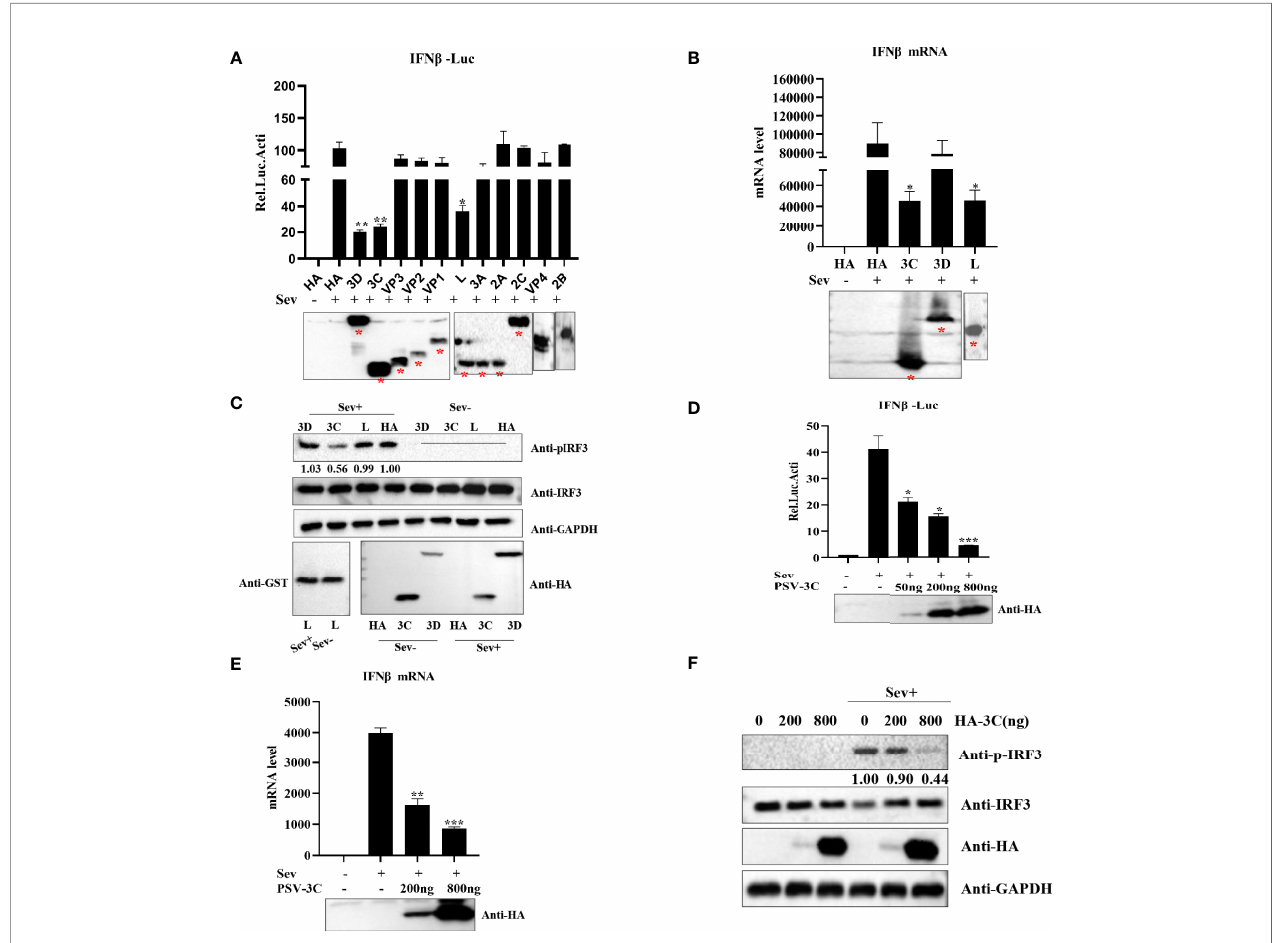
FIGURE 2 | PSV 3C pro suppresses Sev-induced type I IFN production. (A) HEK293T cells were seeded in 24-well plates, and the monolayer cells were co- transfected with 300-ng plasmids expressing indicated PSV viral protein or empty plasmids and 100 ng IFN b -Luc along with 5 ng pRL-TK for 20 h, and then the cells were infected or uninfected with Sev (2 5 HA) for 12 h. The cells were then subjected to dual-luciferase assays. PSV viral protein expression was detected by Western blotting. (B) HEK293T cells were seeded in 24-well plates, and the monolayer cells were transfected with 300-ng empty plasmids, GST- L, HA-3C, or HA-3D for 20 h, and then the cells were infected with Sev (2 5 HA) or not. The mRNA expression level of IFN- b was measured by qPCR assay, and housekeeping gene GAPDH was used as the control. L, 3C pro , or 3D expression was detected by Western blotting. (C) HEK293T cells were seeded in 12-well plates, and the monolayer cells were transfected with 500 ng GST-L, HA-3C, and HA-3D for 20 h, and then the cells were infected with Sev (2 5 HA) or not. The cells were collected for Western blotting. (D) HEK293T cells were co-transfected with different doses of 3C pro -expressing plasmids (0 ng, 50 ng, 200 ng, 800 ng) and 100 ng IFN b -Luc along with 5 ng pRL-TK for 20 h. The cells were infected with Sev (2 5 HA) or not for 12 h. The cells were then subjected to dual-luciferase assays. 3C pro expression was detected by Western blotting using the HA antibody. (E) HEK293T cells were transfected with different doses of 3C-expressing plasmids (0 ng, 200 ng, 800 ng) for 20 h and then infected or not with Sev (2 5 HA) for the indicated times. The mRNA expression level of IFN- b was evaluated with qPCR assays, and housekeeping gene GAPDH was used as the control. 3C pro expression was detected by Western blotting using the HA antibody. (F) HEK293T cells were transfected with different doses of HA-3C (0 ng, 200 ng, 800 ng) for 20 h, and then the cells were infected or uninfected with Sev (2 5 HA). The cells were collected for Western blotting. Data are represented as means ± SD. Student ’ s t-test: *P < 0.05, **P < 0.01, ***P <